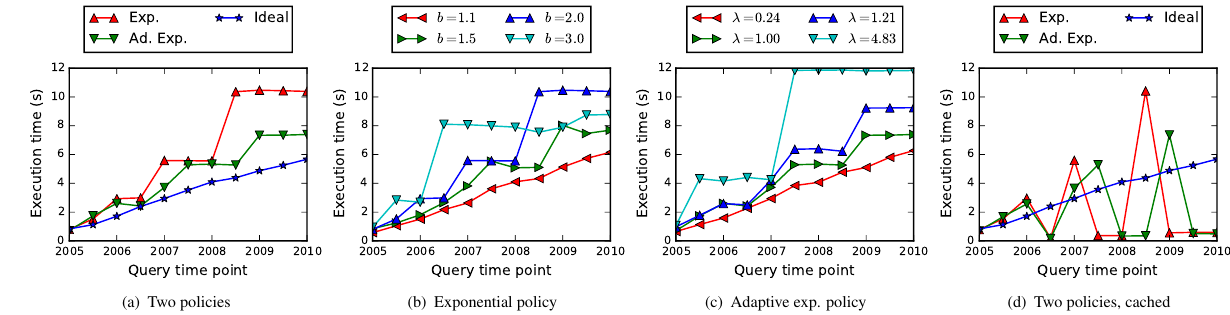
Fig. 8 Global query performance on wiki-fr graph with different time-split policies and